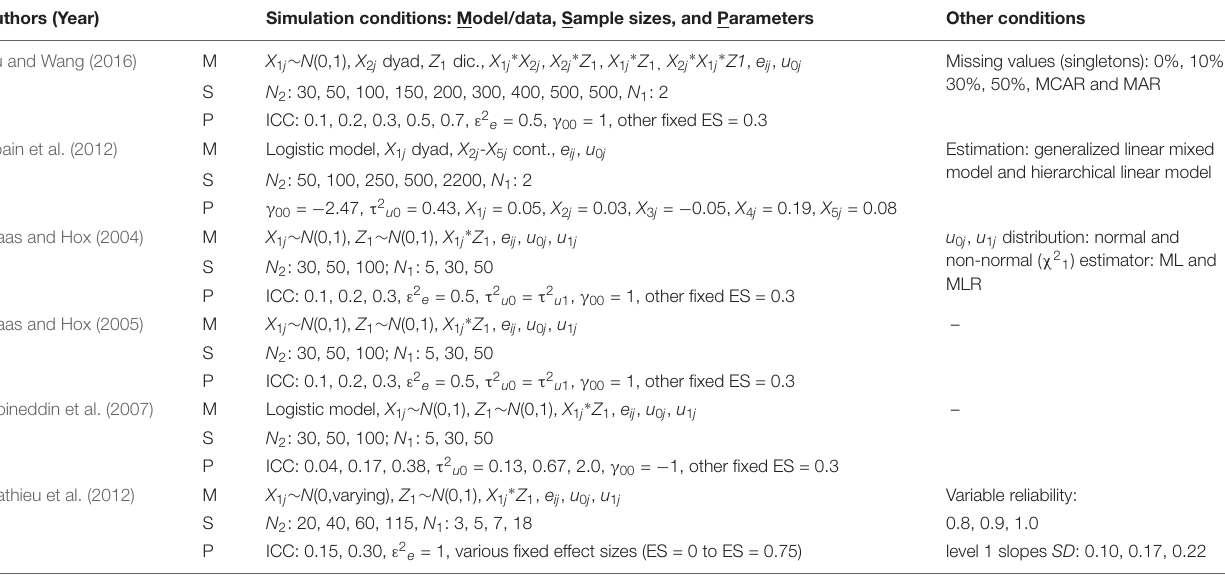
TABLE 1 | Investigated parameters of studies examining the impact of sample sizes on estimation results in two-level models. Authors (Year) Simulation conditions: Model/data, Sample sizes, and Parameters Other conditions